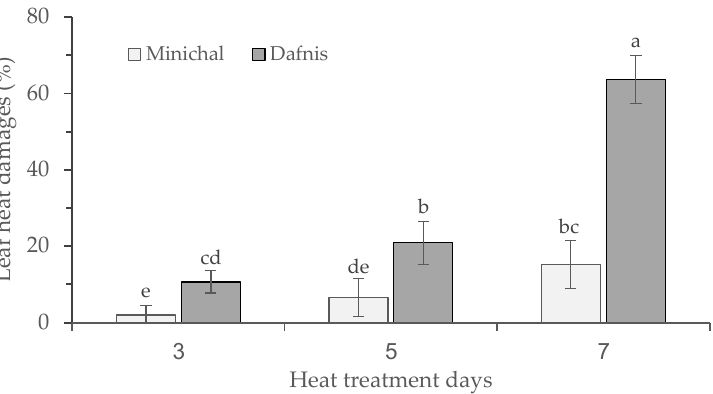
Figure 1. Changes in leaf heat damages among tomato cultivar seedlings Minichal and Dafnis. Vertical bars represent ± SD (n = 4). Means with different letters indicate significant differences at p ≤ 0.05.